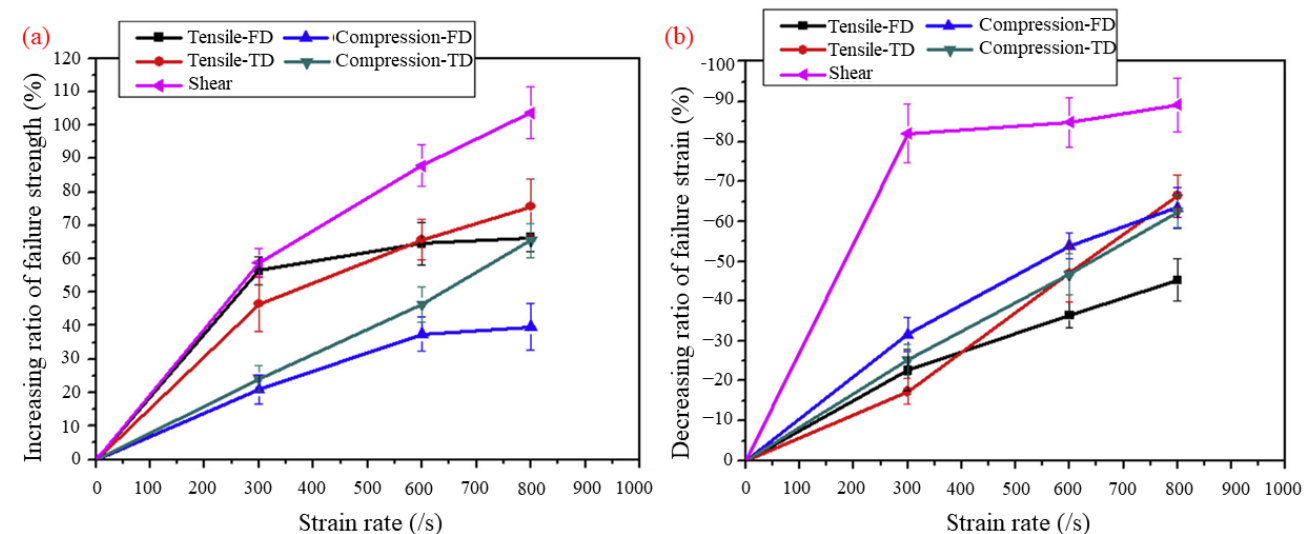
Figure 14. Experimental results for strain rate-dependent mechanical properties of GFPP, including the fiber direction, transverse direction, and shear: ( a ) increasing ratio of ultimate failure strength; ( b ) decreasing ratio of failure strain [36].